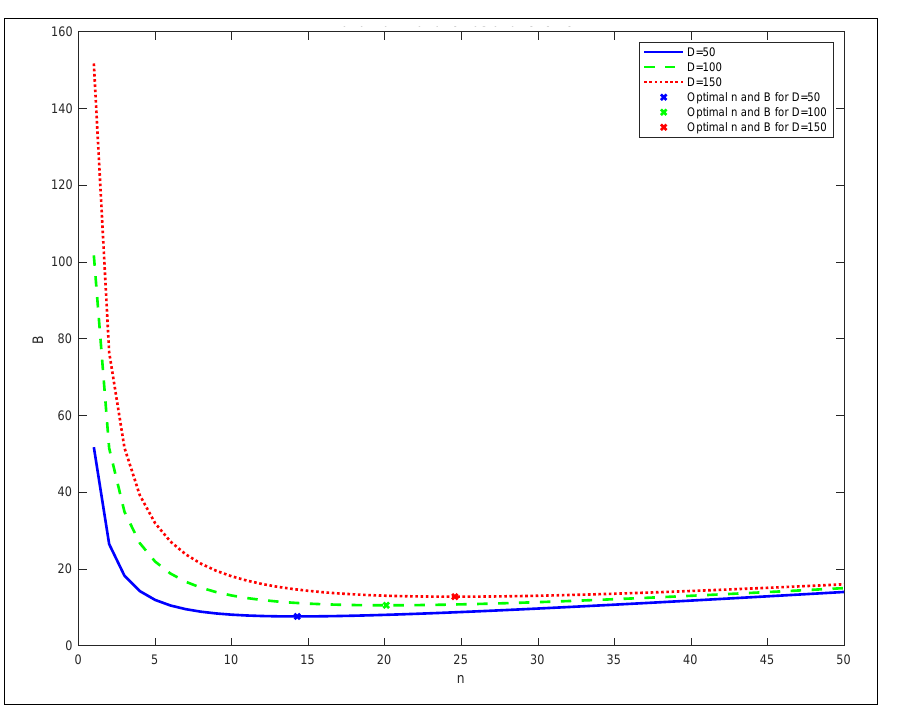
Figure 4. SASST average bandwidth variation as a function of n